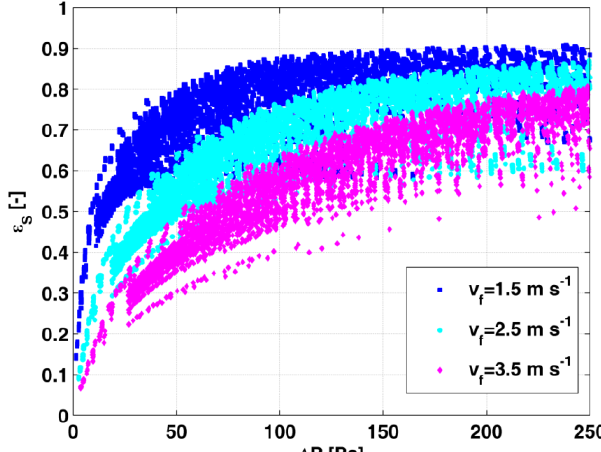
Figure 7. Sensible effectiveness against pressure drop for different heat wheel geometry and boundary conditions (see Table 3, T su,in = 10 °C, T ex,in = 30 °C, X su,in = 3.7 g·kg −1 , X ex,in = 3.7 g·kg −1 , φ su,in = 50% and φ ex,in = 30%).